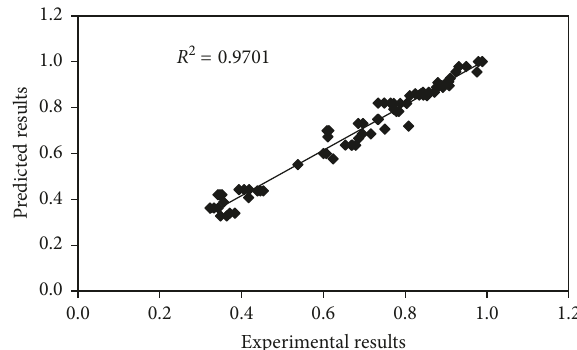
Figure 19: Linear relationship between measured and predicted compressive strengths of support vector machine model.